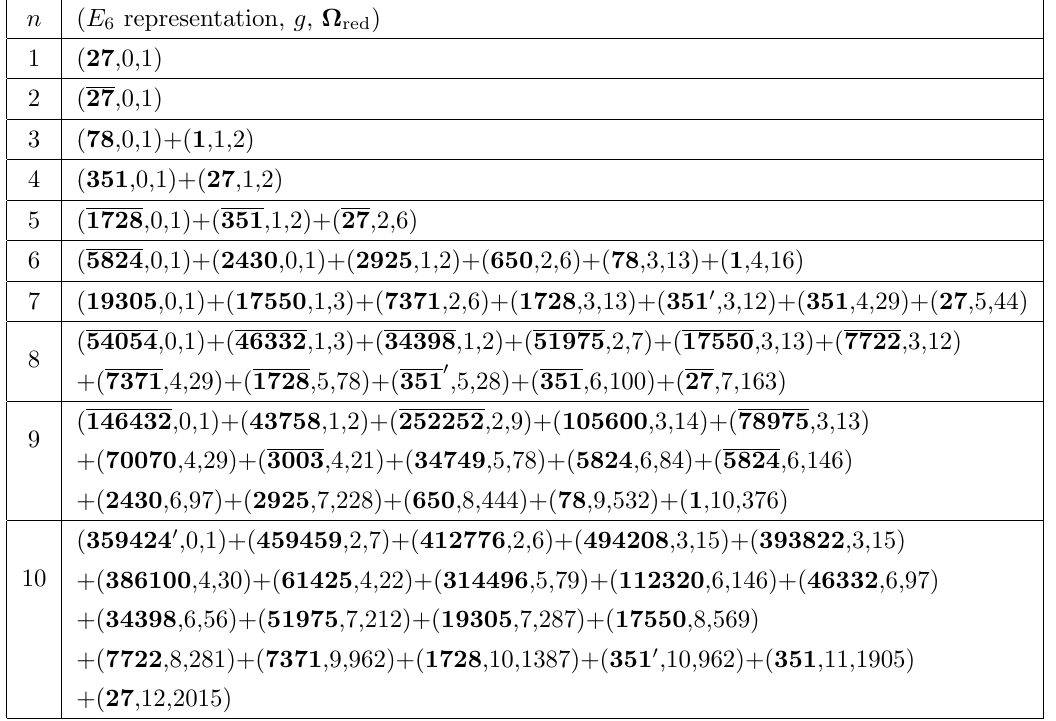
(cid:12)ve A-branes, the B-brane and the two C-branes. Plugging (3.1) into (2.4) we (cid:12)nd